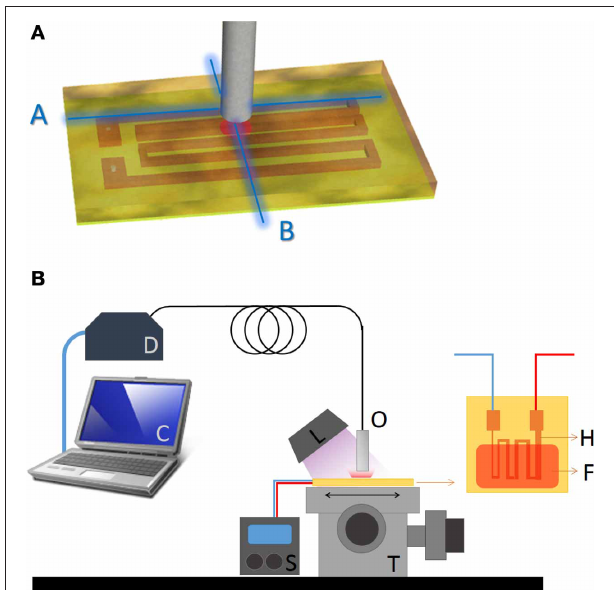
FIGURE 1 | (A) Geometry of the FR4 printed wiring board where A and B characterize the directions used in temperature mappings. (B) Schematic representation of the setup used. The heating circuit (H) was covered with a UET–1.3 film (F) and positioned over a translation stage (T). The temperature was controlled by the source (S). A handheld UV lamp (L) was used to excite the film. The optical fiber (O) was connected to the portable detector (D) and the emission spectra were processed in the computer